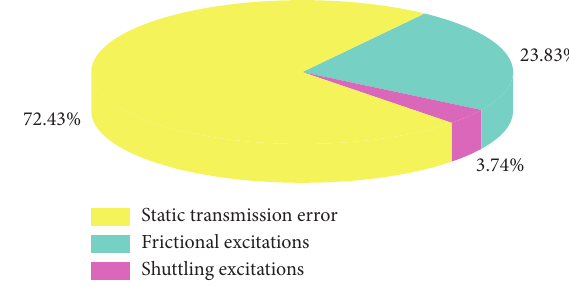
Figure 4: Gear whine noise excitation